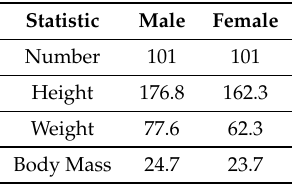
Table 2. Population descriptive